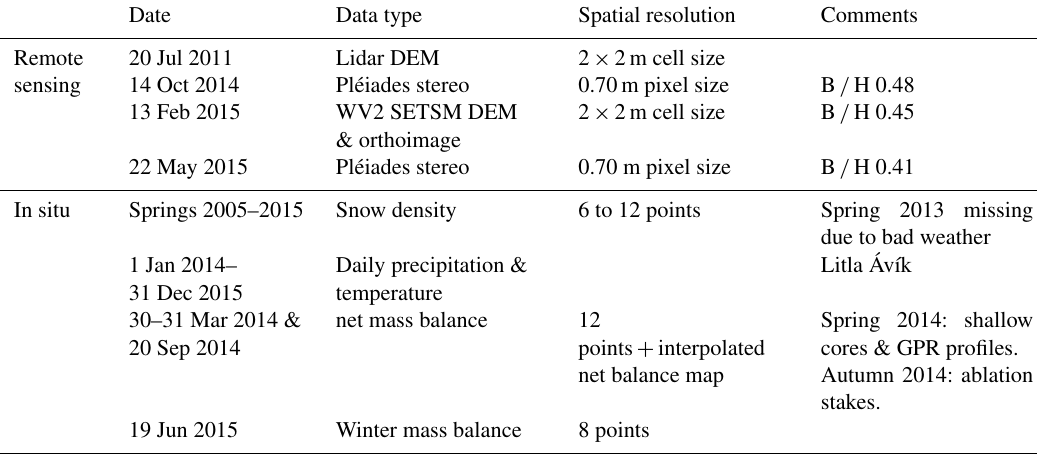
Figure 1. Area of study and data collected. (Left) Mosaic of Iceland from Landsat 8 images, mosaicked by the National Land Survey of Iceland. The blue rectangle locates the Drangajökull ice cap, and a blue dot indicates the location of the meteorological station “Litla Ávík” (LÁ). L, M, V and H represent the locations of Langjökull, Mýrdalsjökull, Vatnajökull and Hofsjökull ice caps, respectively. (Right) A shaded relief representation of a lidar DEM covering Drangajökull and vicinity in the summer 2011 (Jóhannesson et al., 2013). Margins of the ice cap are shown as a black polygon, and the equilibrium line altitude (ELA) obtained from the mass balance measurements over 2013–2014 is shown with a green dashed line. Blue dots indicate location of the in situ measurements. Locations labeled V1–7 have been measured since 2005, whereas locations labeled J1–5 were only measured in 2014 except J2, which was also measured in 2015. Black rectangles show the footprints of the Pléiades images, and a green rectangle shows the footprint of the WV2 DEM. Table 1. Dates, type of data (split between remote sensing and in situ data), sampling and specifications of datasets used in this study. Date Data type Spatial resolution